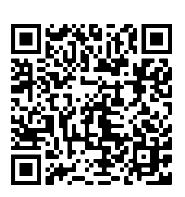
Video 3 – Performing mitral valve repair and